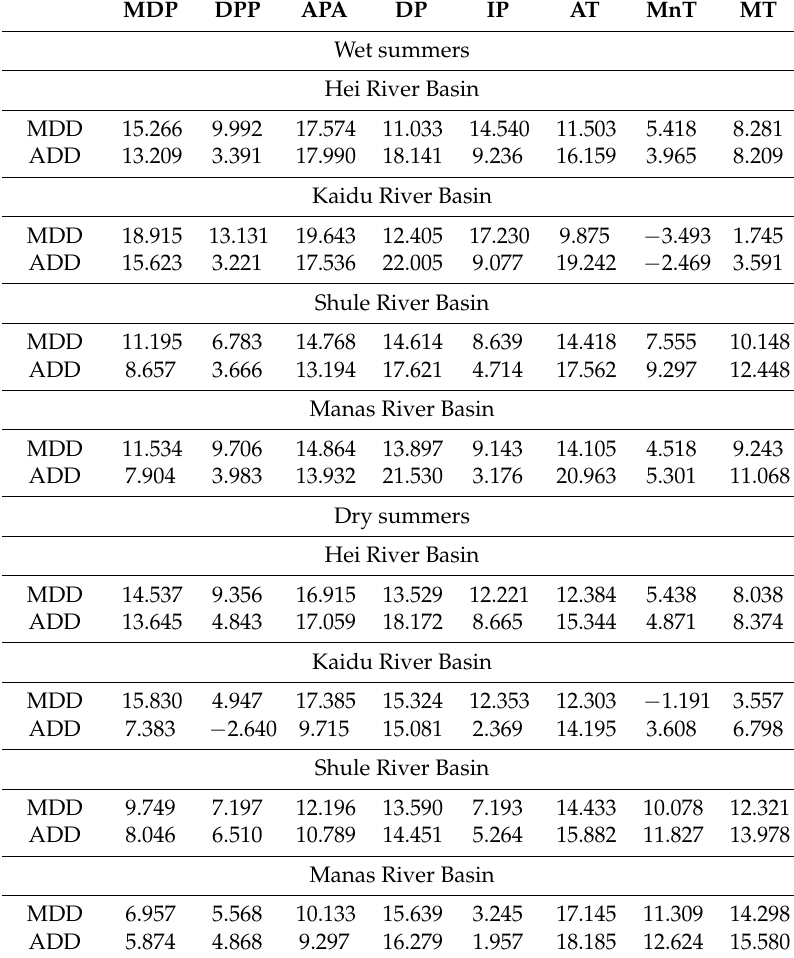
Table 8. Contributions of eight precipitation and temperature indices to the variations in the runoff indices during wet and dry summers. Unit: